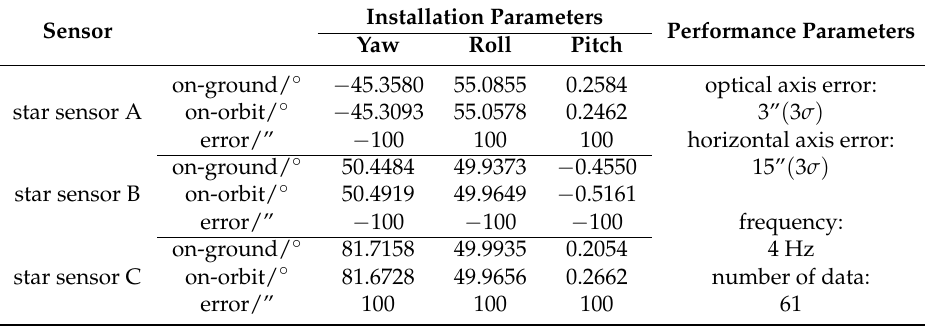
Table 1. Simulation parameters of the star sensor.